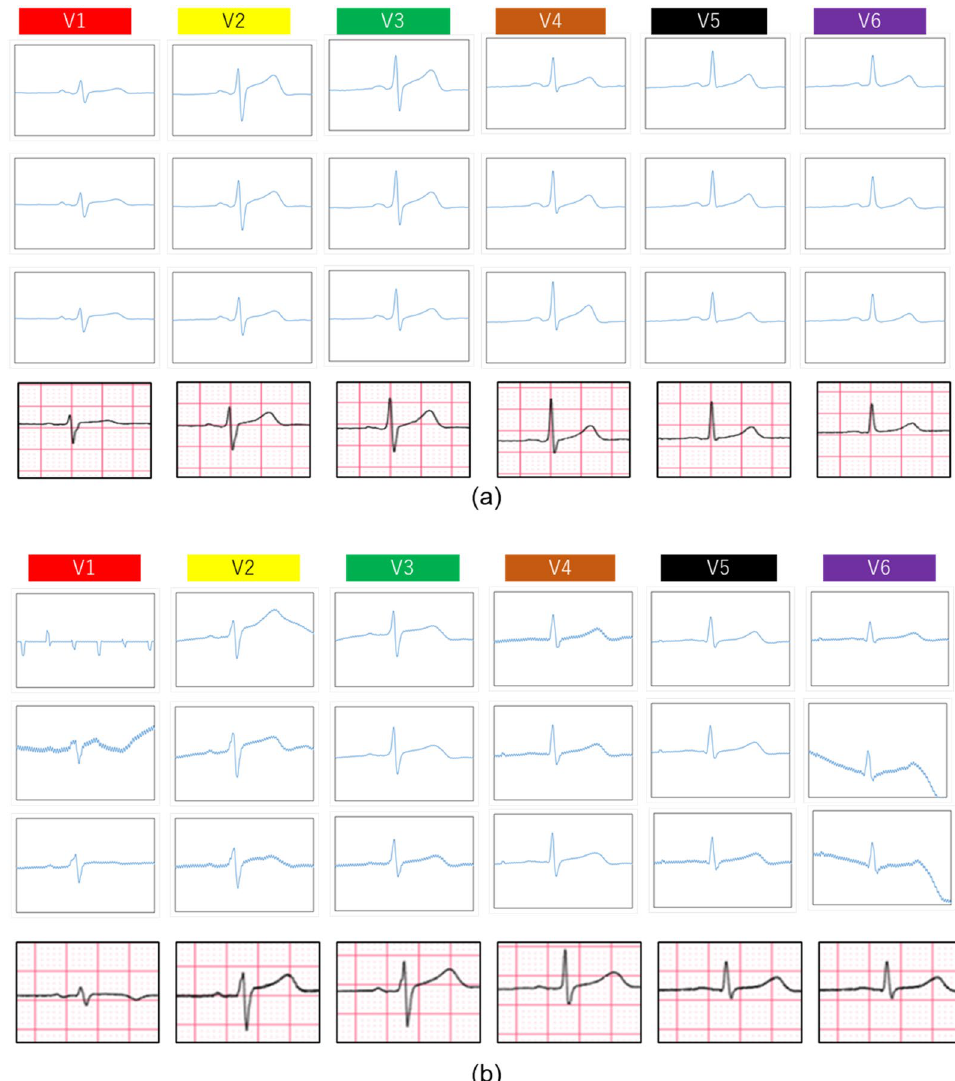
Figure 5. The 18-lead ECG signals measured by the wearable multi-lead ECG measurement device and by a commercial medical product around the chest. ( a ) Best quality ECG from 10 subjects, and ( b ) worst quality ECG from 10